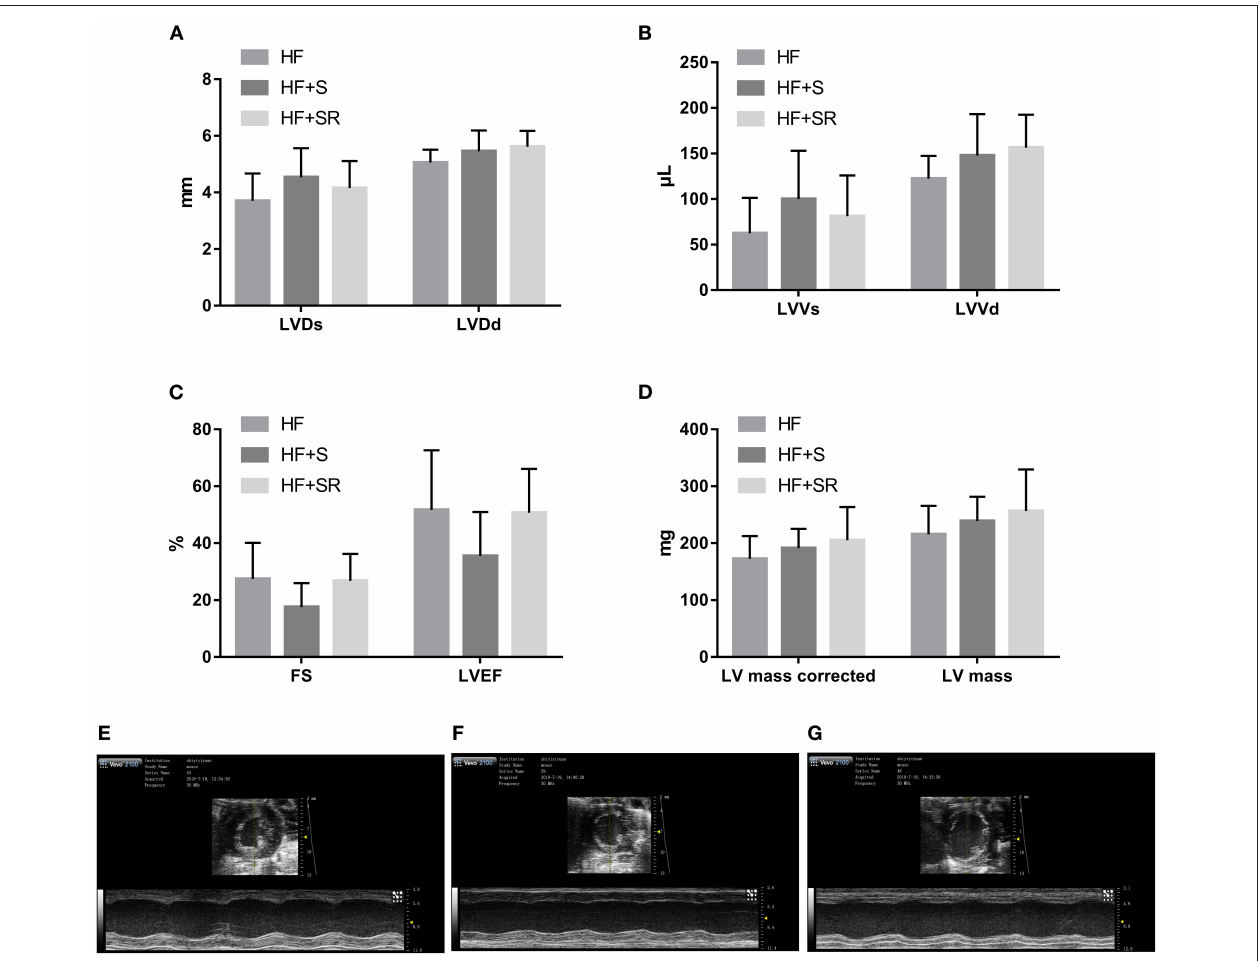
FIGURE 2 | Difference in the echocardiographic parameters among the HF ( n = 5), HF + S ( n = 8) and HF + SR ( n = 8) mice at 14 days after administration. There were no differences in LVDs, LVDd (A) , LVVs, LVVd (B) , FS, LVEF (C) , LV mass or LV mass corrected (D) among the three groups. Representative echocardiographic images showing cardiac function and dimensions in the HF (E) , HF + S (F), and HF + SR (G)